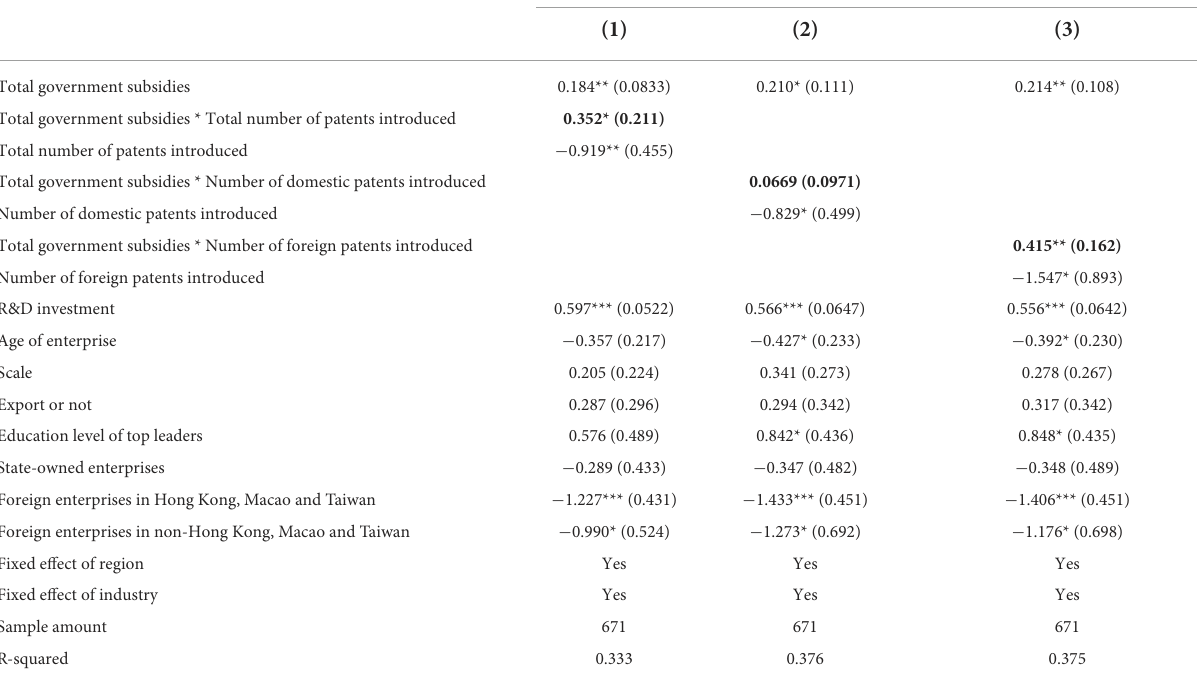
TABLE 4 Government subsidies and enterprises “imitative